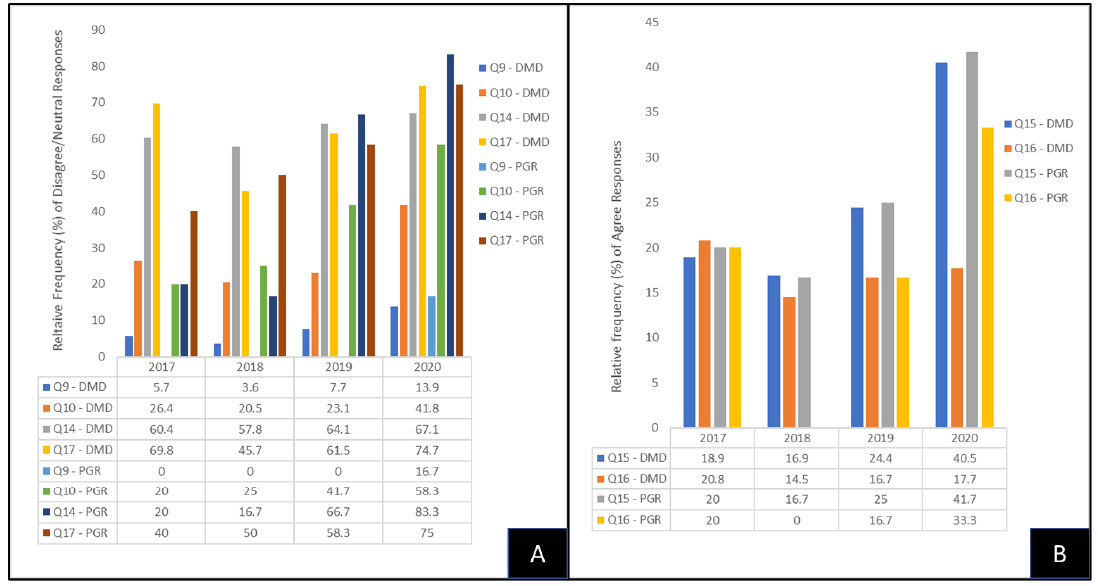
Figure 2. Graphic analysis of pro- and anti-HPV vaccine response among DMD students and PG residents. ( A ) Relative frequency of disagree/neutral responses to pro-HPV vaccines questions (Q9 — HPV vaccine awareness; Q10 — HPV vaccine important for me; Q14 — Discussed HPV vaccines with doctor; Q17 — Received HPV vaccine) increased over time in both DMD and PGR cohorts. ( B ) Relative frequency of agree responses to anti-HPV vaccine questions (Q15 — Not enough information about HPV vaccine; Q16 — Concerned about HPV vaccine side effects) also increased over time in both DMD and PGR cohorts.